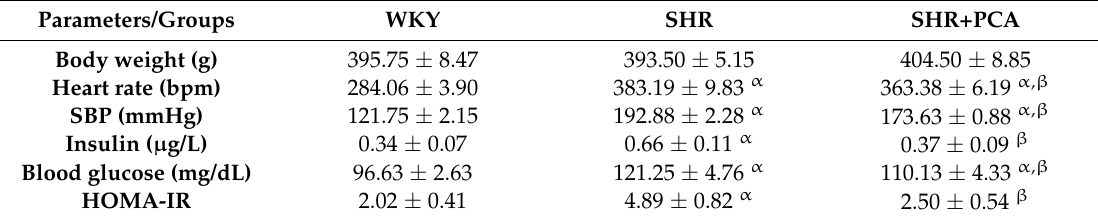
Table 1. General